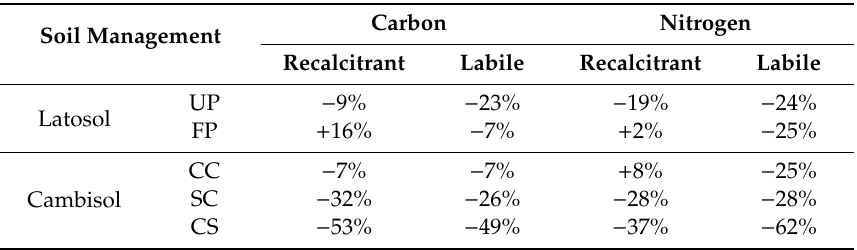
Table 4. Carbon and nitrogen losses (labile and recalcitrant) for latosol (unfertilized